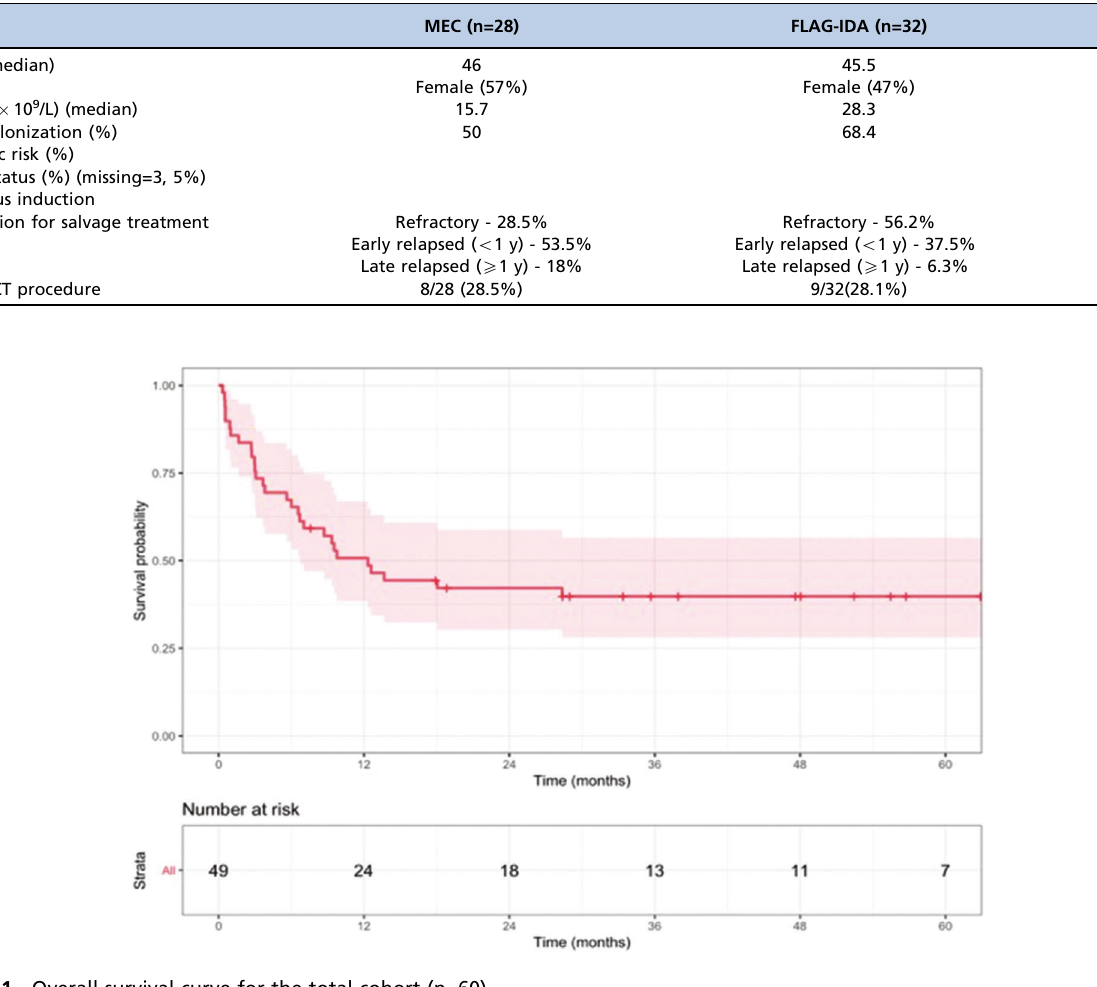
Figure 1 - Overall survival curve for the total cohort (n=60).